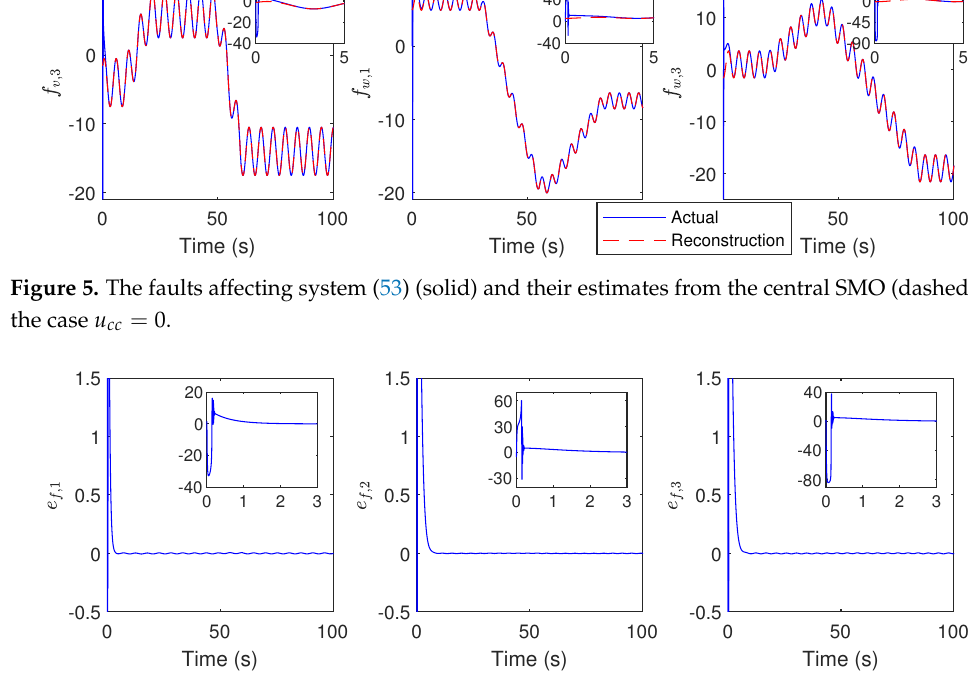
Figure 6. Fault estimation errors for the central SMO when u cc =